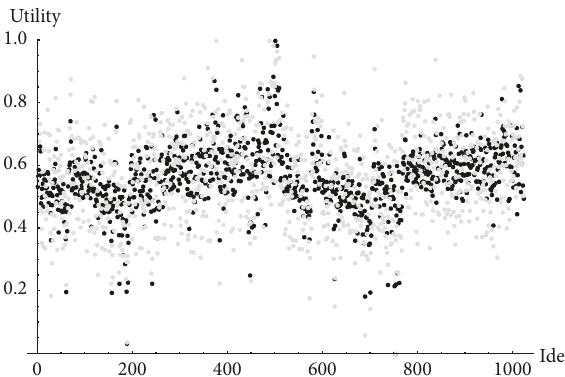
Figure 1: Master and Individual Utility Functions . Note: The master utility function with M = 10, generated from a representative set of idea utilities of size n = 10, is shown by black dots. An individual utility function by adding noise with 𝜉 = 0.2 is shown by gray dots. The x -axis shows idea indices generated by interpreting bit strings as binary notations of an integer; i.e., all of different ideas are lined up along the horizontal axis and their utility values are